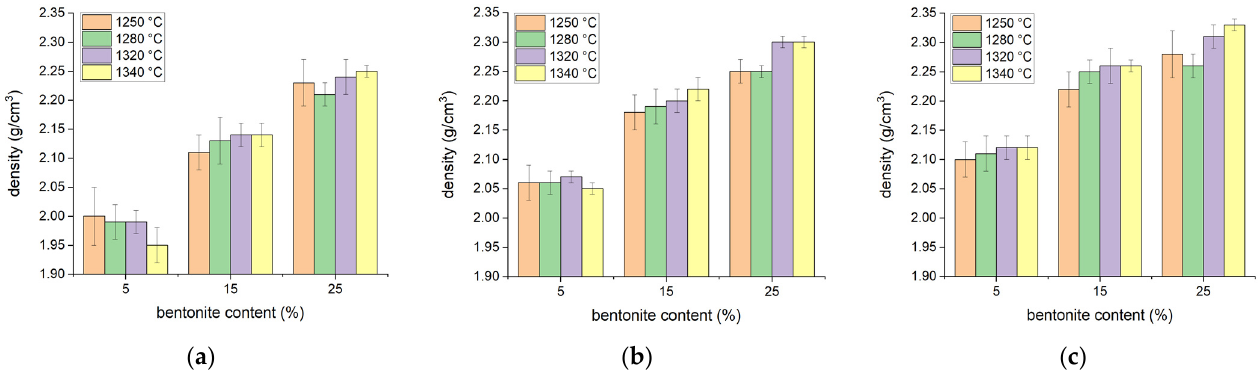
Figure 5. Content of bentonite binder vs. density of ceramics based on hollow alumina microspheres (HAM) pressed at ( a ) 20; ( b ) 30; and ( c ) 40 MPa. Sintering temperature is indicated in a legend.